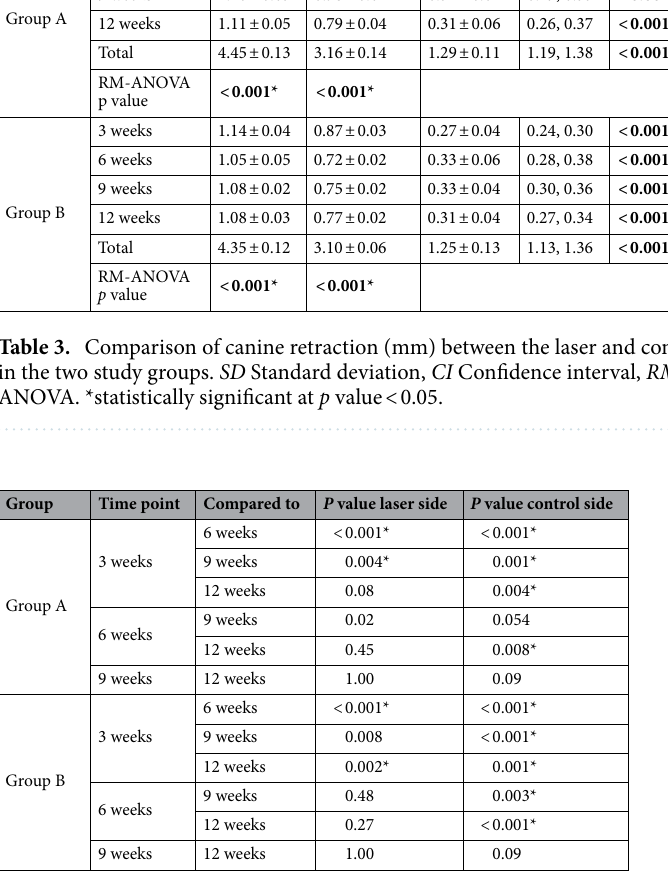
Table 4. Post-hoc pairwise comparisons of canine retraction at different time points, within the laser and control sides of each study group. *Statistically significant using Bonferroni adjusted significance level.